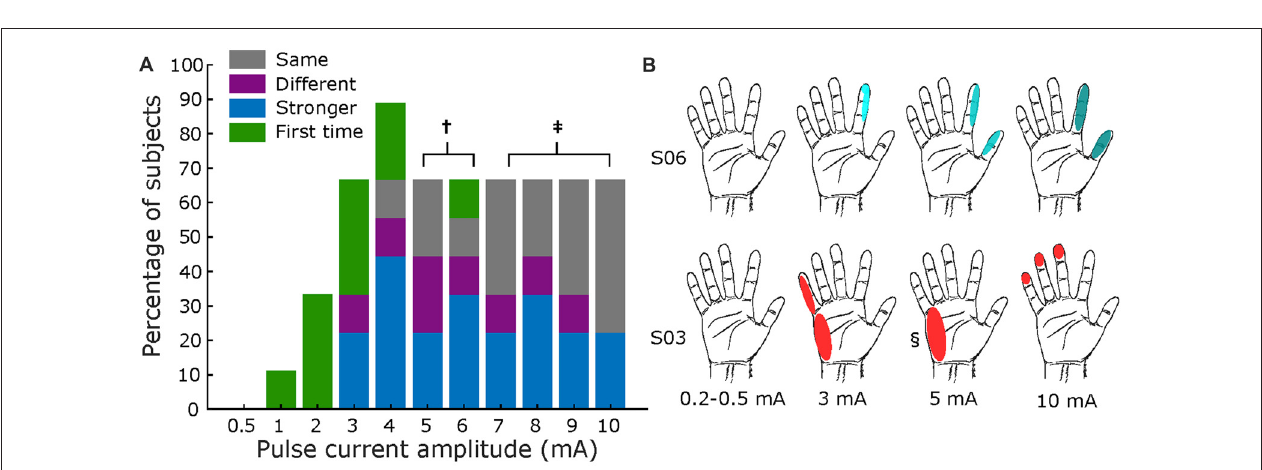
FIGURE 6 | Amplitude mapping. (A) Percentage of subjects that reported sensations across tested current amplitudes. Same format as Figure 5 . Total subjects: nine, fixed pulse width = 500 µ s, and fixed frequency = 50 Hz († values tested in seven subjects; ‡ tested in six subjects). (B) Exemplar receptive fields for S03 and S06, darker shades represent a stronger sensation. Main elicited sensations were “shock” for S06, and “feeling of movement” for S03. §Sensation different from main: